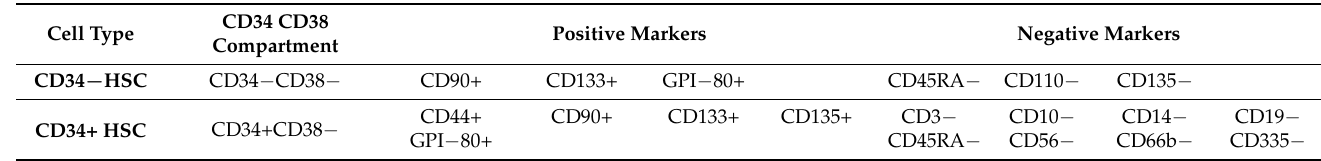
Table 1. Overview of the different CD markers that are positive or negative on the different subtypes of hematopoietic stem cells and myeloid progenitor